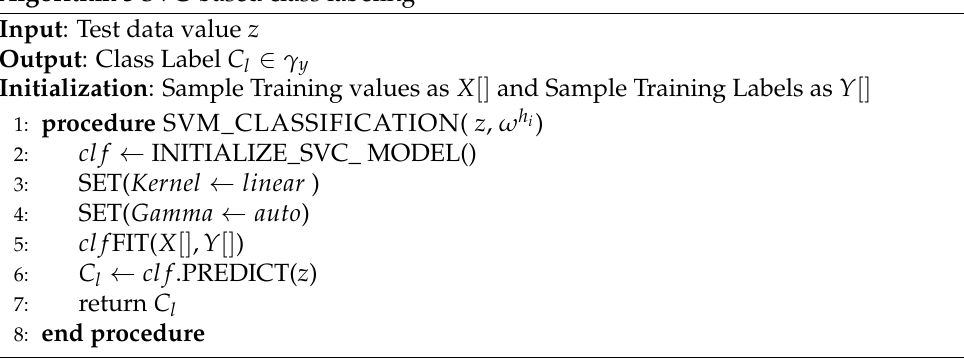
Algorithm 3 SVC-based class labeling